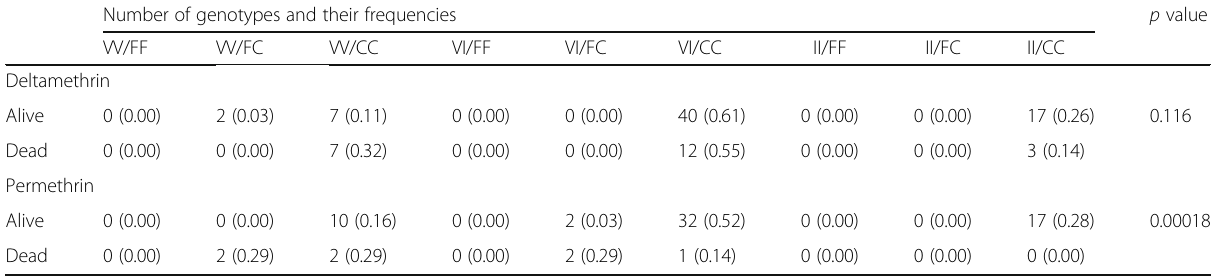
Numbers in brackets indicate the genotype frequency; mutant alleles are shown in